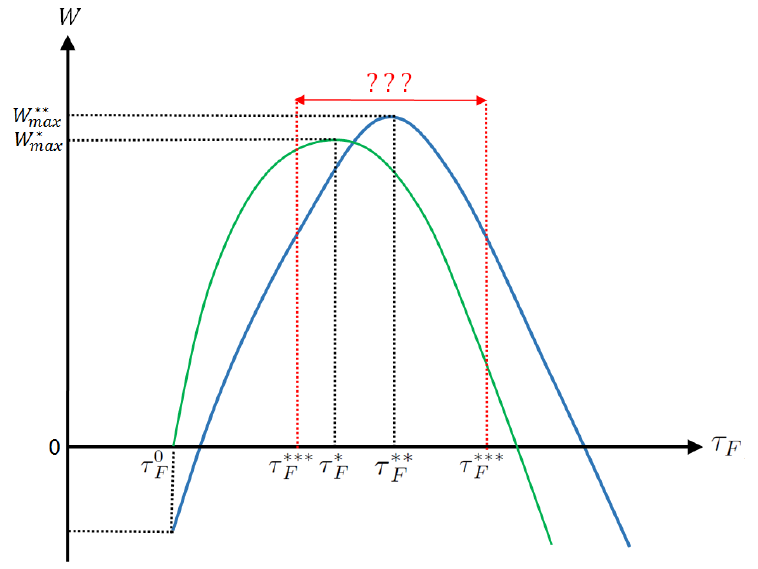
Figure 2. Optimal transport